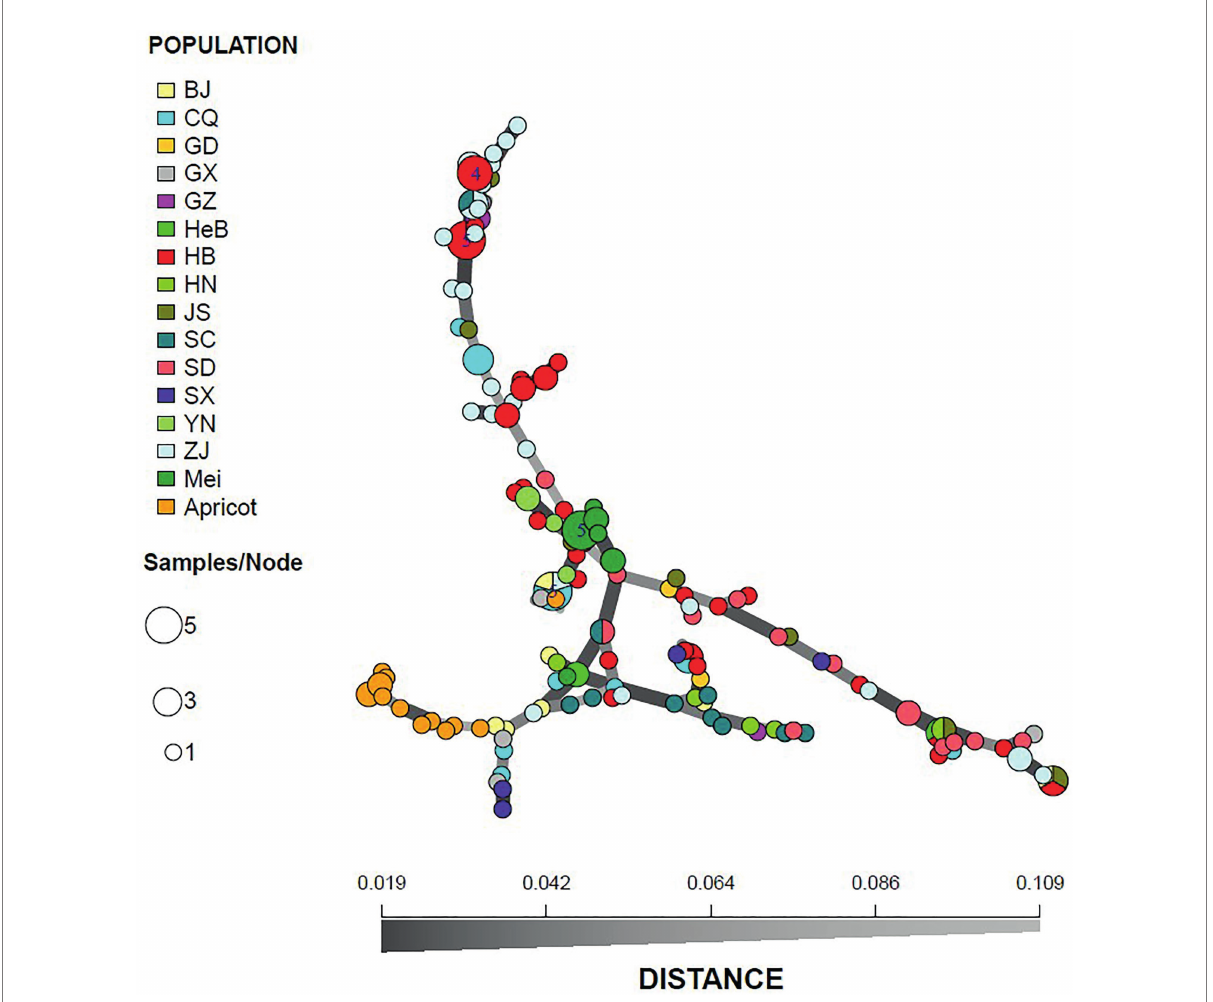
FIGURE 8 Minimum spanning network of 186 Venturia carpophila based on genetic distance from 14 geographic and 3 host populations. Node colors represent population membership and are proportional to the pie size. There is no representation of clonal individuals in this